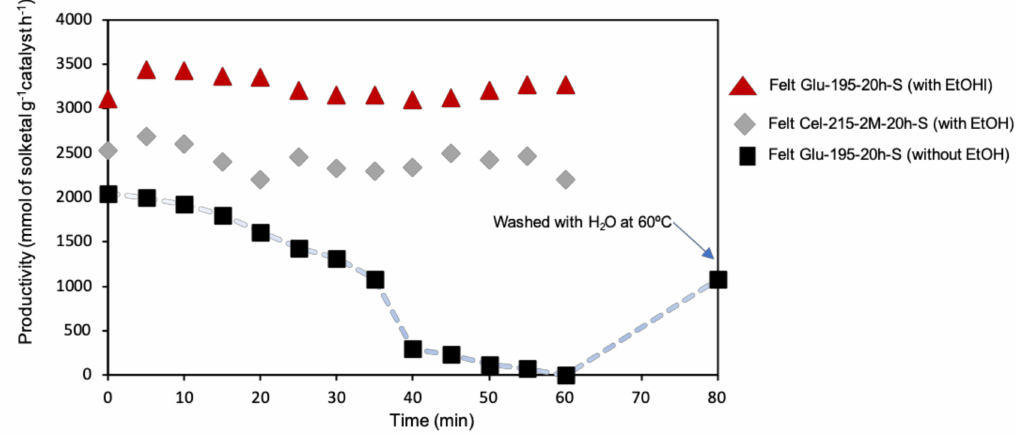
Figure 11. Solketal productivity in continuous flow at 25 ◦ C using 10 mmol / min of glycerol (WHSV 1175 h − 1 ) and acetone / glycerol molar ratio of